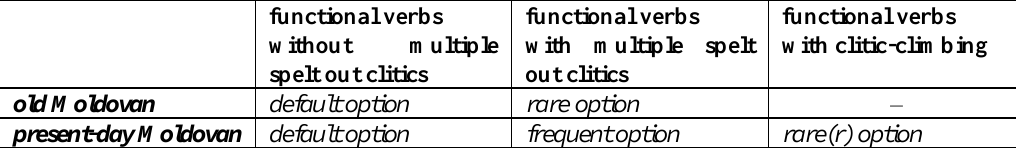
Table 7. Changes in the structure of Moldovan predicates containing subjunctives functional verbs functional verbs functional verbs without multiple with multiple spelt with clitic-climbing spelt out clitics out clitics old Moldovan default option rare option – present-day Moldovan default option frequent option rare(r)